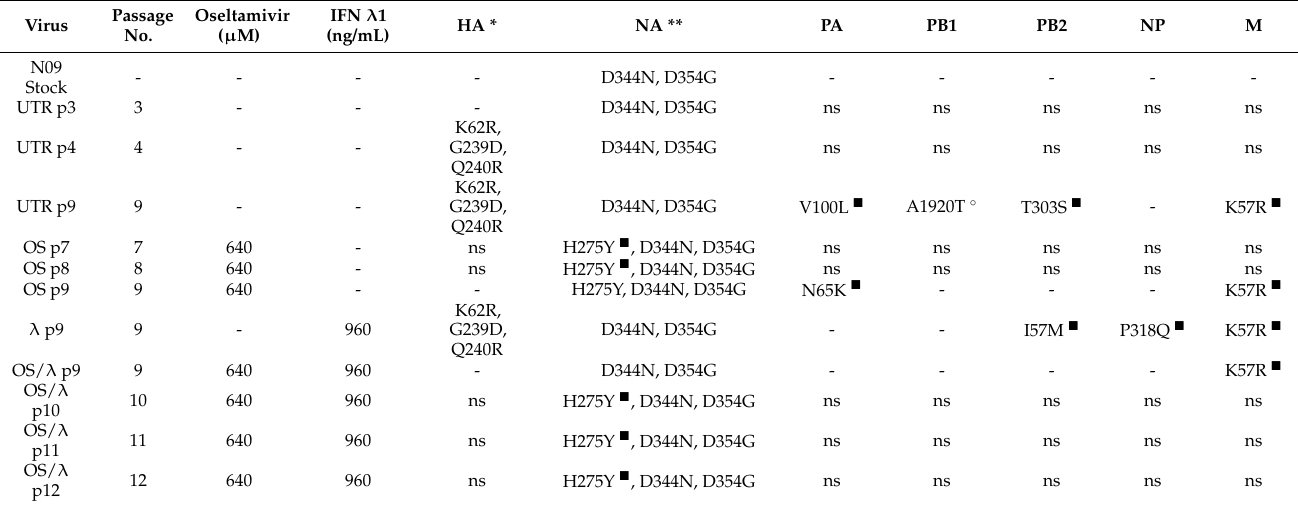
Table 2. Amino acid changes identified by sanger sequencing in selected A(H1N1)pdm09 variants. Virus Passage